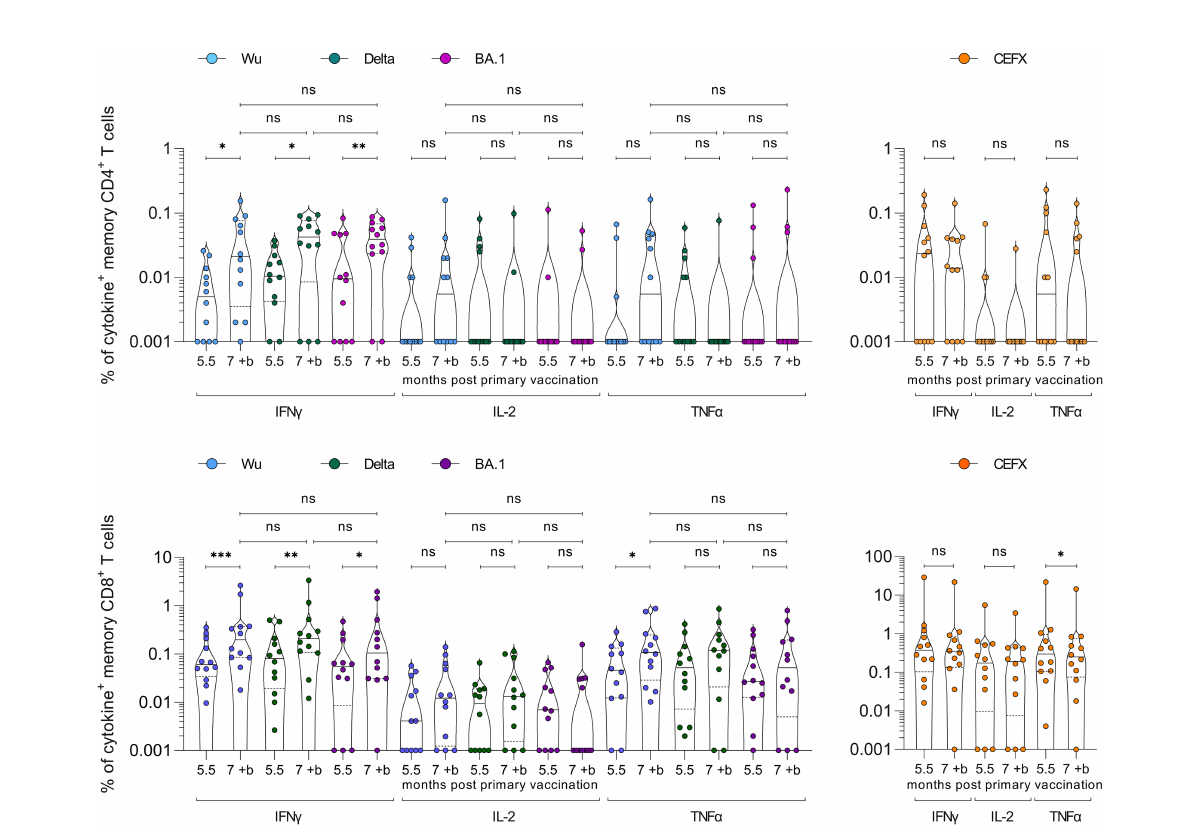
FIGURE 3 SARS-CoV-2 spike-speci fi c CD4 + and CD8 + memory T cell responses after heterologous vaccination followed by a ‘ booster ’ vaccination. PBMCs isolated from samples of n = 12 study participants were obtained 5.5 months after the heterologous primary vaccination, and 2 weeks after the BNT162b2 ‘ booster ’ (7 months post primary vaccination). PBMCs were stimulated with SARS-CoV-2 Wuhan-Hu-1 (Wu), Delta, or Omicron (BA.1) spike peptide-pool (left panels) or control pools of different infectious agents (CEFX, right panels) and cytokine production determined by fl ow cytometry. CD4 + (upper panel) and CD8 + (lower panel) memory T cells were gated and analysed for IFN g , IL-2, and TNF a cytokine production. Cytokine + T cells were background-corrected for unstimulated cells (Figures S2, S3), and zero values set to 0.001%. Wilcoxon matched-pair signed-rank test compares cytokine-positive cells before and after the ‘ booster ’ . Mann – Whitney-U test compares cytokine-positive cells post ‘ booster ’ between variants. ***p < 0.001, **p < 0.01, *p < 0.05, ns, not signi fi